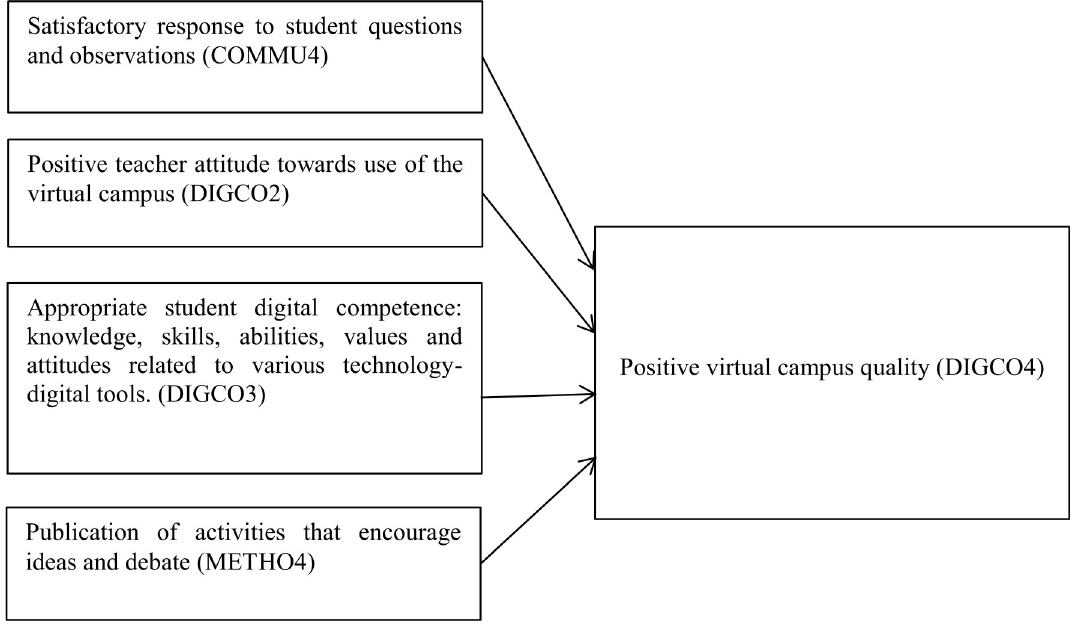
Fig 3. Proposed evaluation model of variables influencing quality of virtual